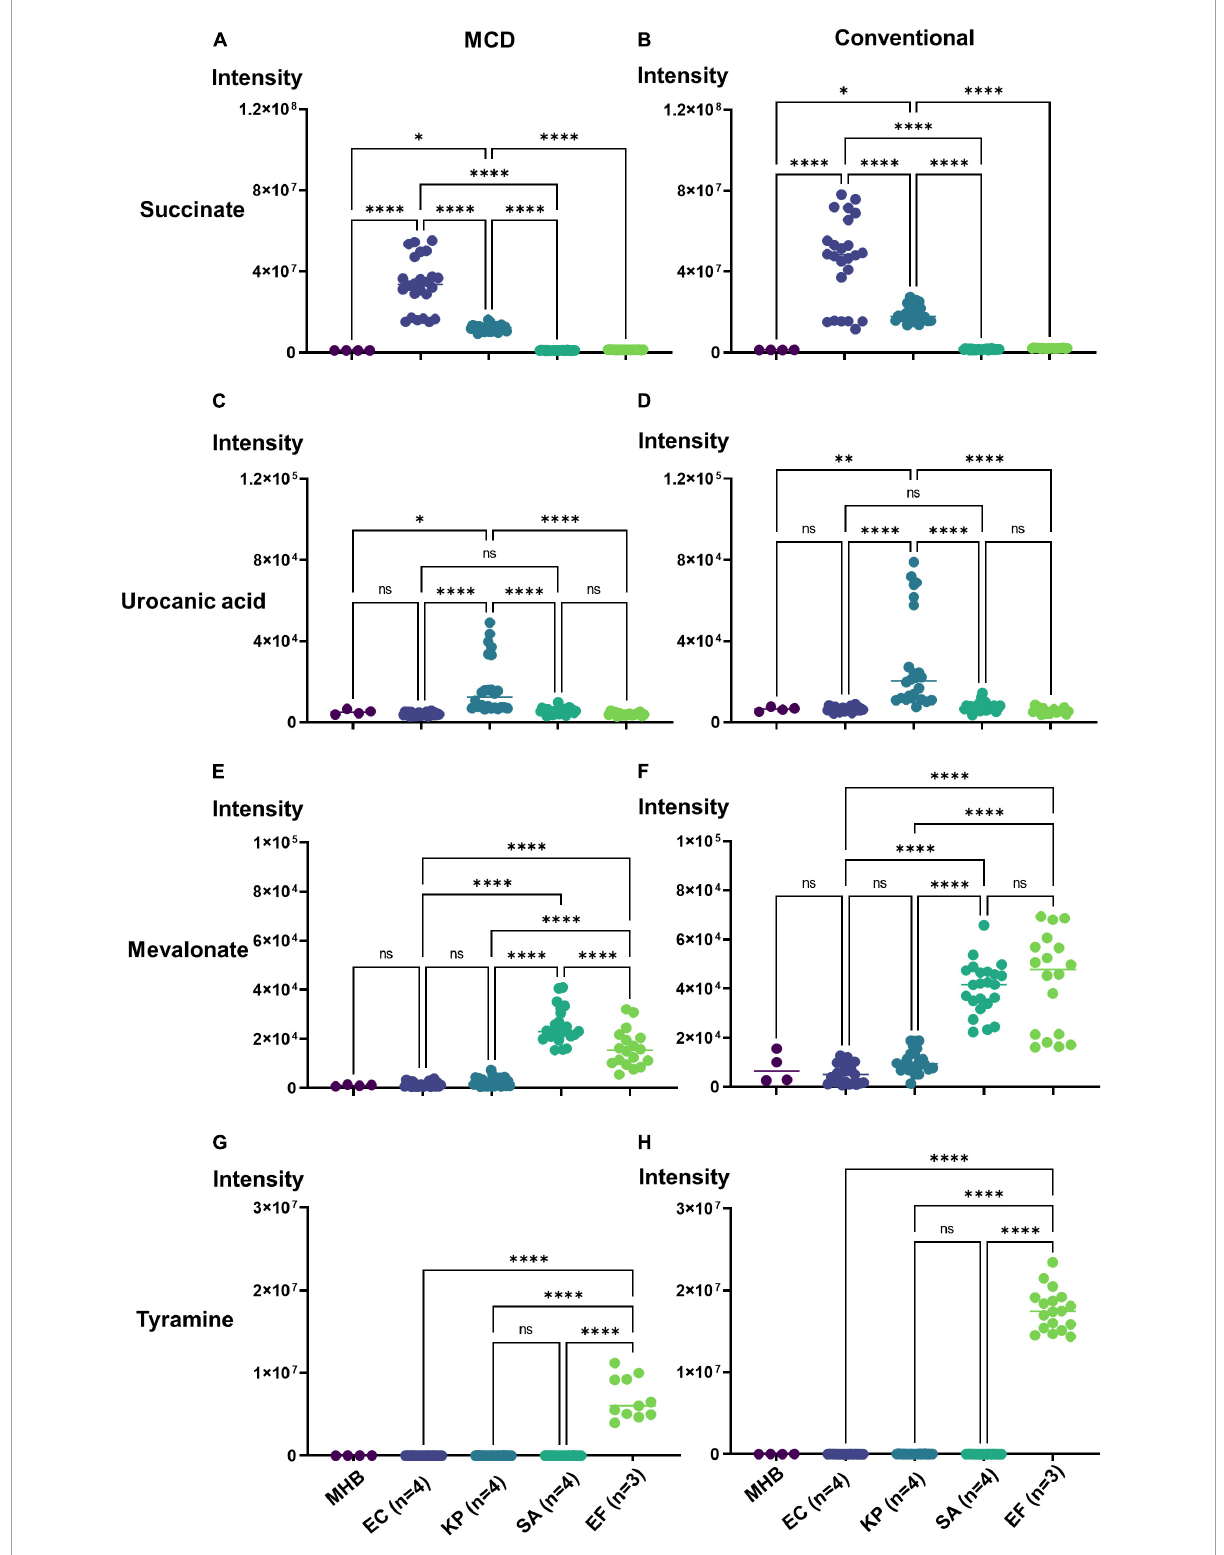
FIGURE5 Bacteria identification using the MCD (A,C,E,G) versus the a conventional metabolomics workflow (B,D,F,H) for EC ( n = 4), KP ( n = 4), EF ( n = 3), and SA ( n = 4), strains. For all plots, ∗ p < 0.05; ∗∗ p < 0.01; and ∗∗∗∗ p <